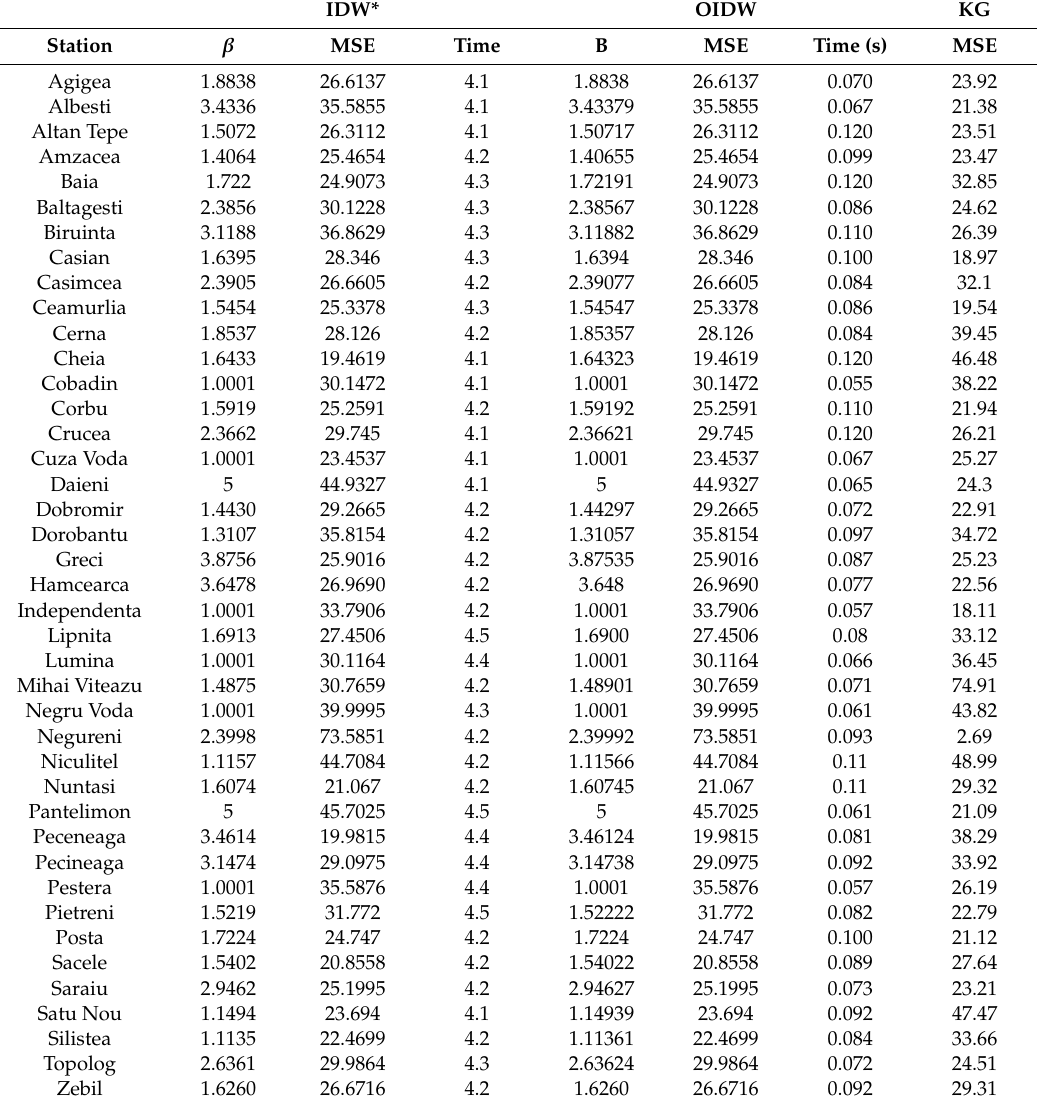
Table 6. Parameter β values obtained in experiments performed using the series recorded at all the meteorological stations in the scenario B2. Comparison with KG.